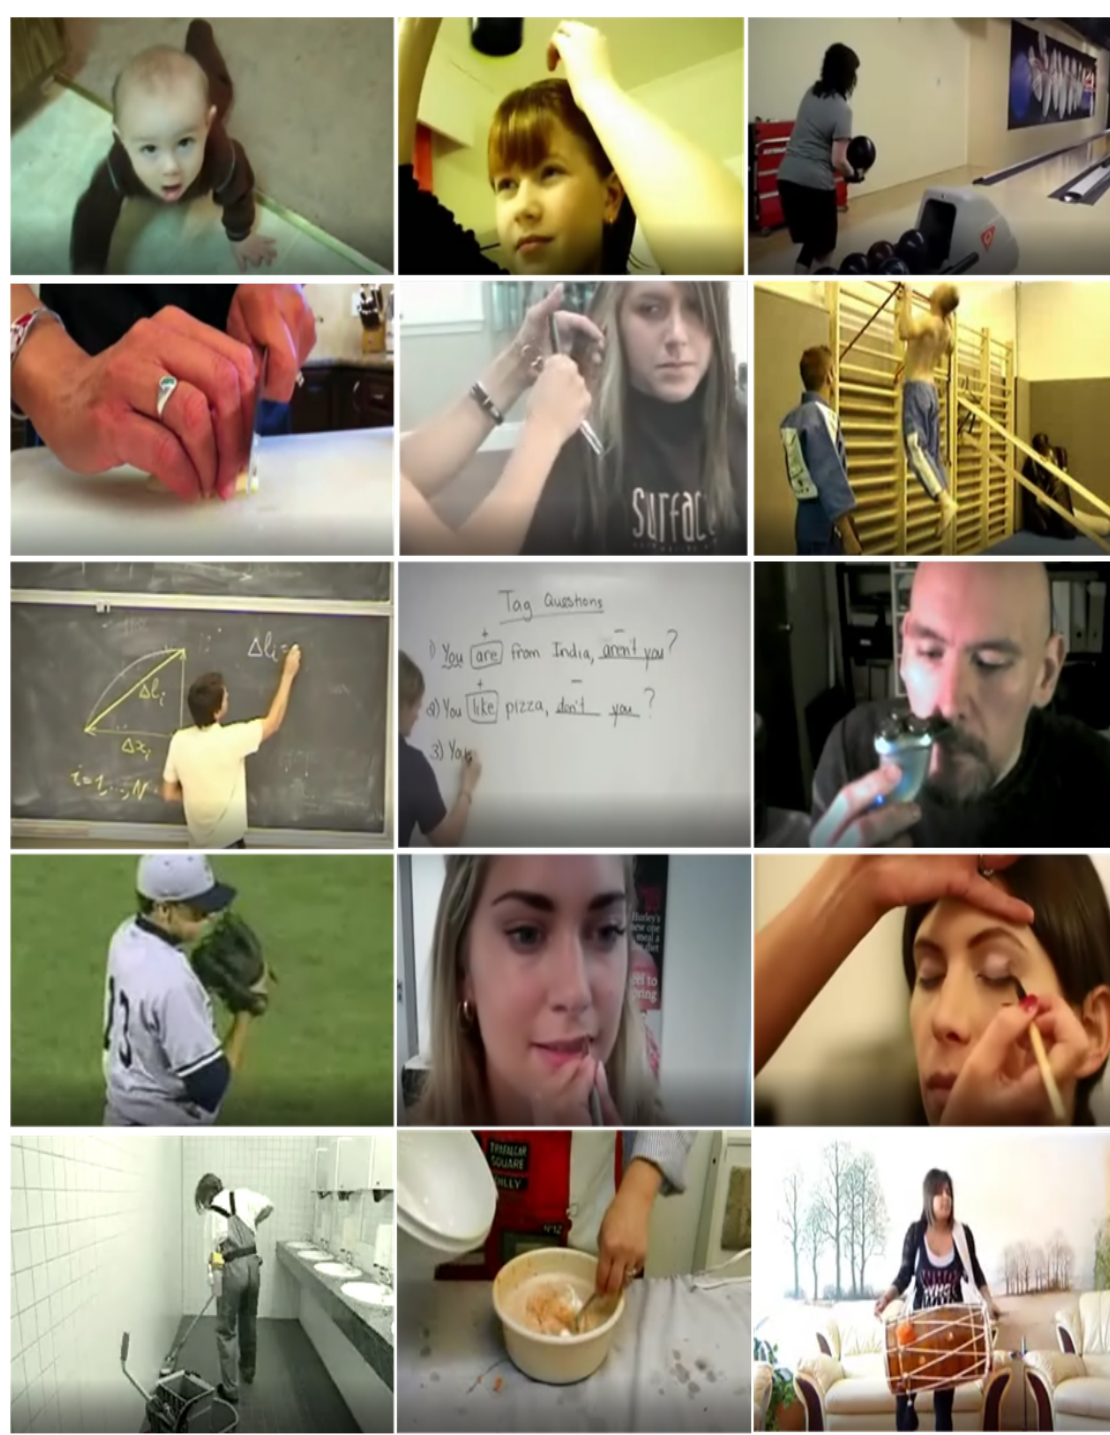
Figure 10. Generated high-resolution frames of the raw